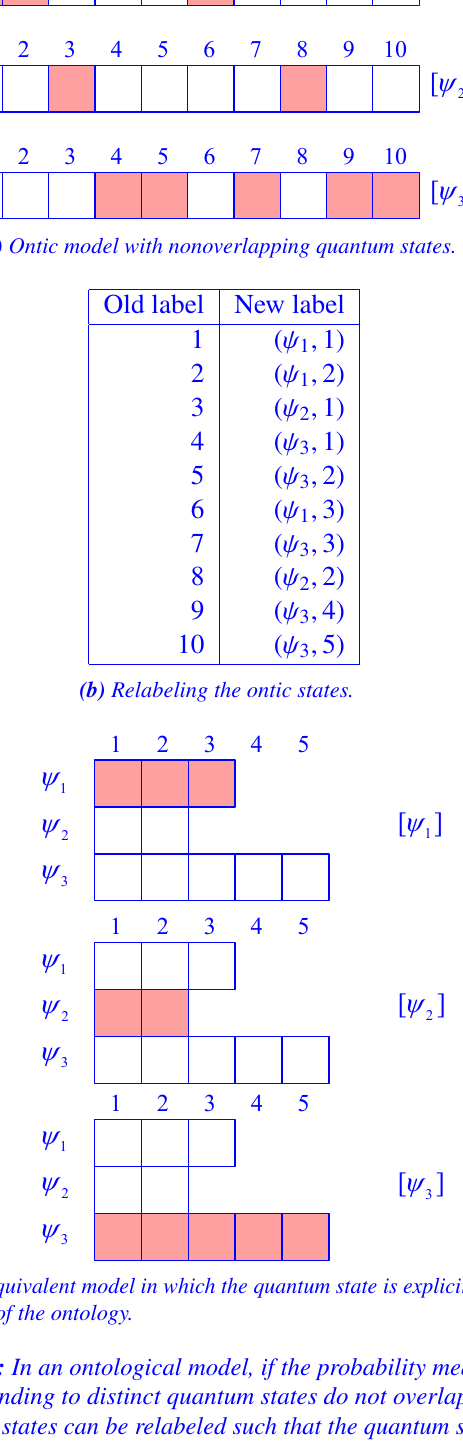
Figure 9: In an ontological model, if the probability measures corresponding to distinct quantum states do not overlap, then the ontic states can be relabeled such that the quantum state is explicitly part of the ontology. Panel (a) depicts the measures corresponding to three quantum states on a discrete ontic state space consisting of the integers from 1 to 10 . Red boxes indicate the ontic states on which the measures have support. Panel (b) shows a one-to-one map to a new ontic state space in which the quantum states are an explicit part of the ontology. The result is shown in Panel